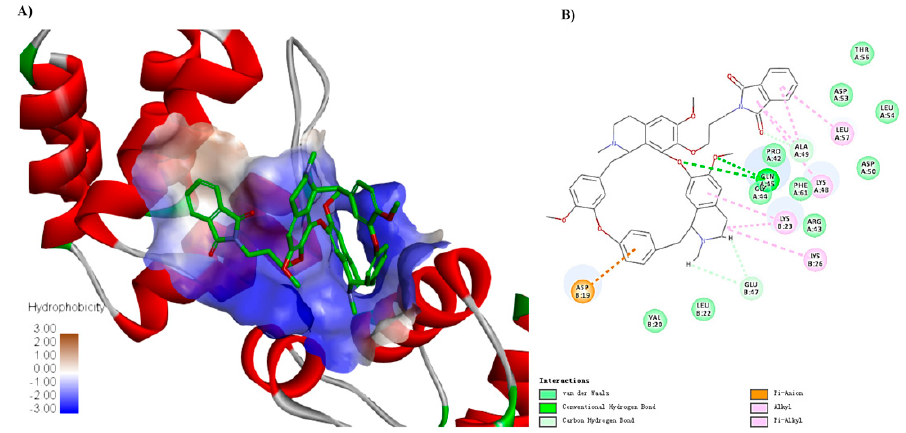
Figure 6. (A ) Solid surface map of the interaction pocket with compound 6 . Red, blue, and white colored regions correspond to negatively charged, positively charged, and neutral areas, respectively. ( B ) Binding modes within the receptor NLRP3 pocket. The receptor structure is shown in surface form. Key bonds are indicated by dashed lines between the atoms involved, and the colors of key bonds and residues are shown according to the interaction mode.